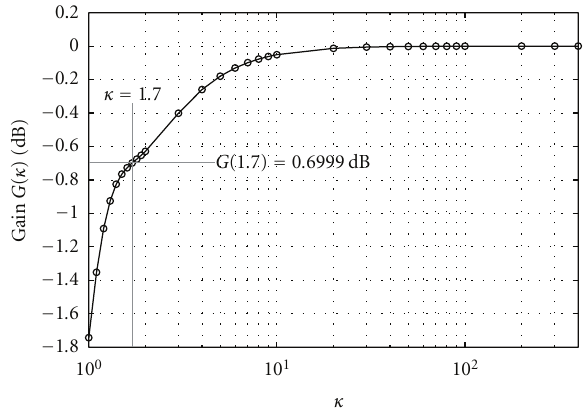
Figure 10: Gain G = Γ ( κ ) as a function of a parameter κ ≥ 1, with which F is chosen as F = κω 2 s U s / 2 and α is set as α = 3 ( T = 0 .